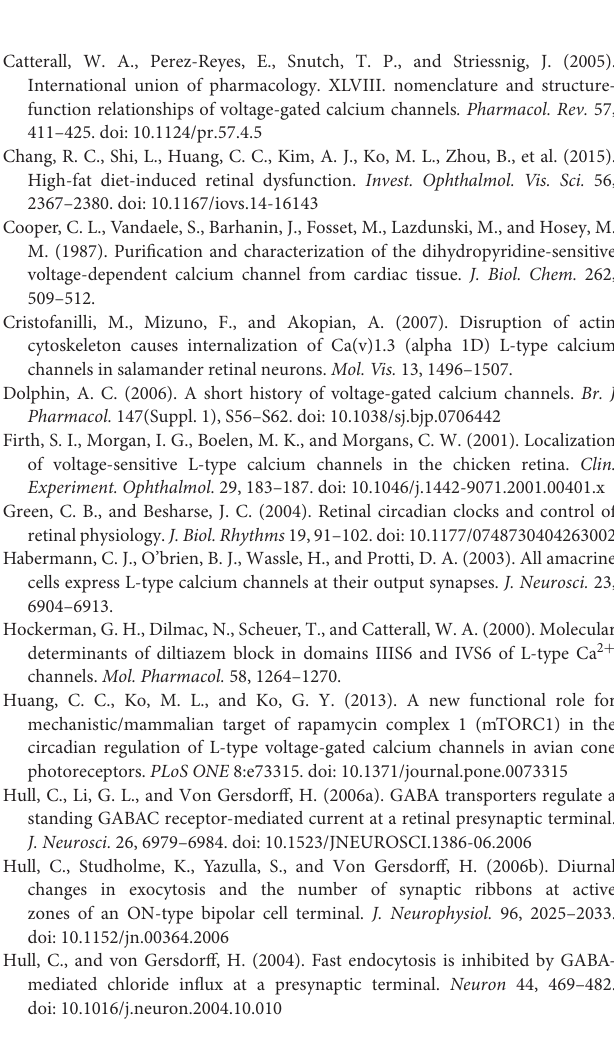
Supplementary Figure 1 | Statistical analyses of synaptic structures at OPL (the Table 3 data plotted). Each datum point represents the average from a single mouse retina. N = 5 (mice) for each group. ∗ p <